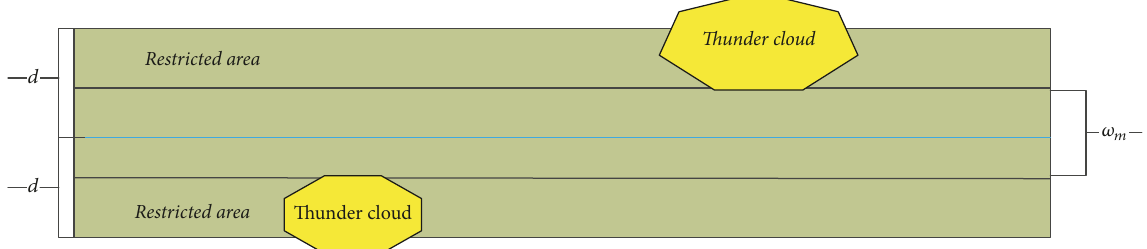
Figure 4: Coverage of the weather module whose minimum cut is not perpendicular to the air route in the terminal area.